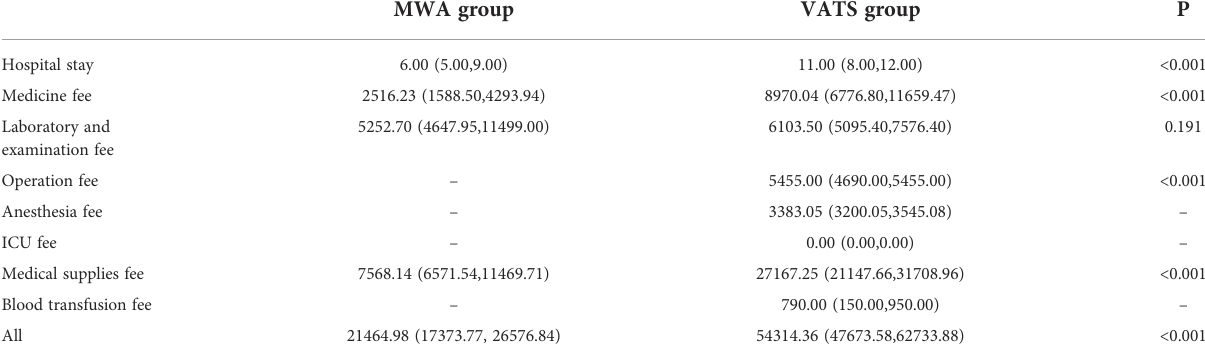
TABLE 2 The comparation of cost between the two groups.